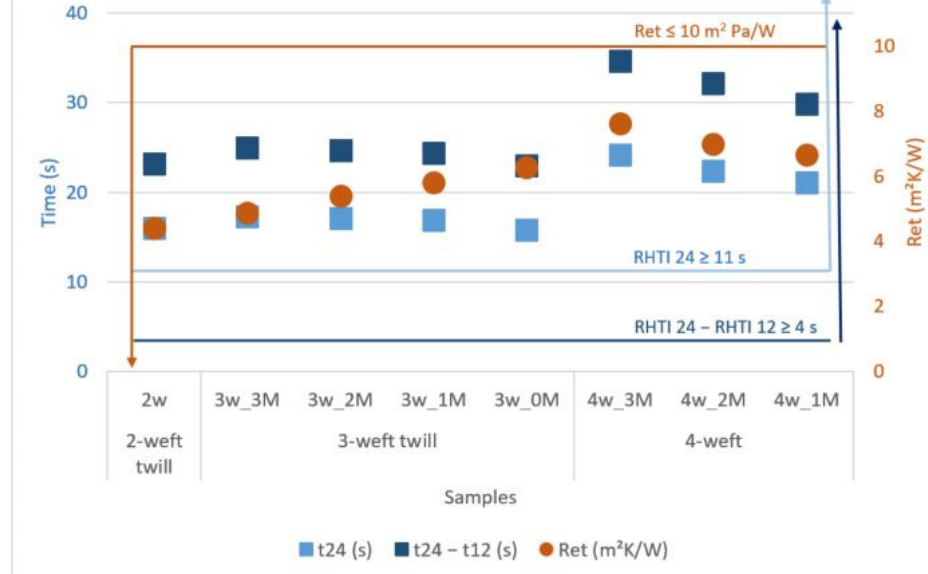
Figure 12. Comparison of the developed samples with the requirements of the standard.